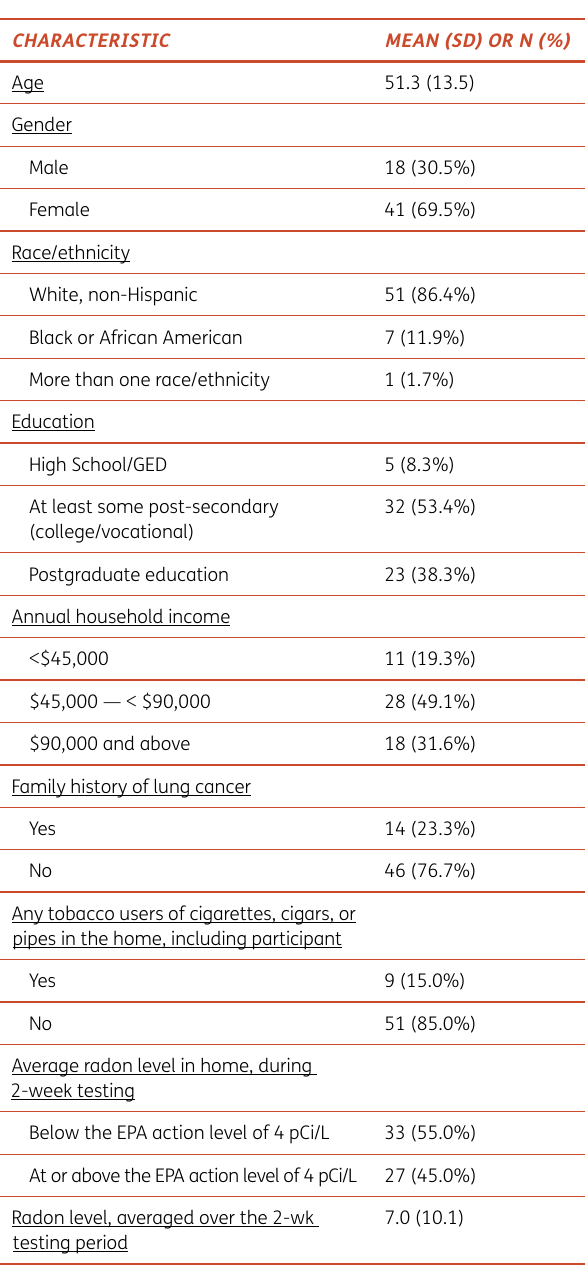
Table 2 Demographic, personal and home characteristics of